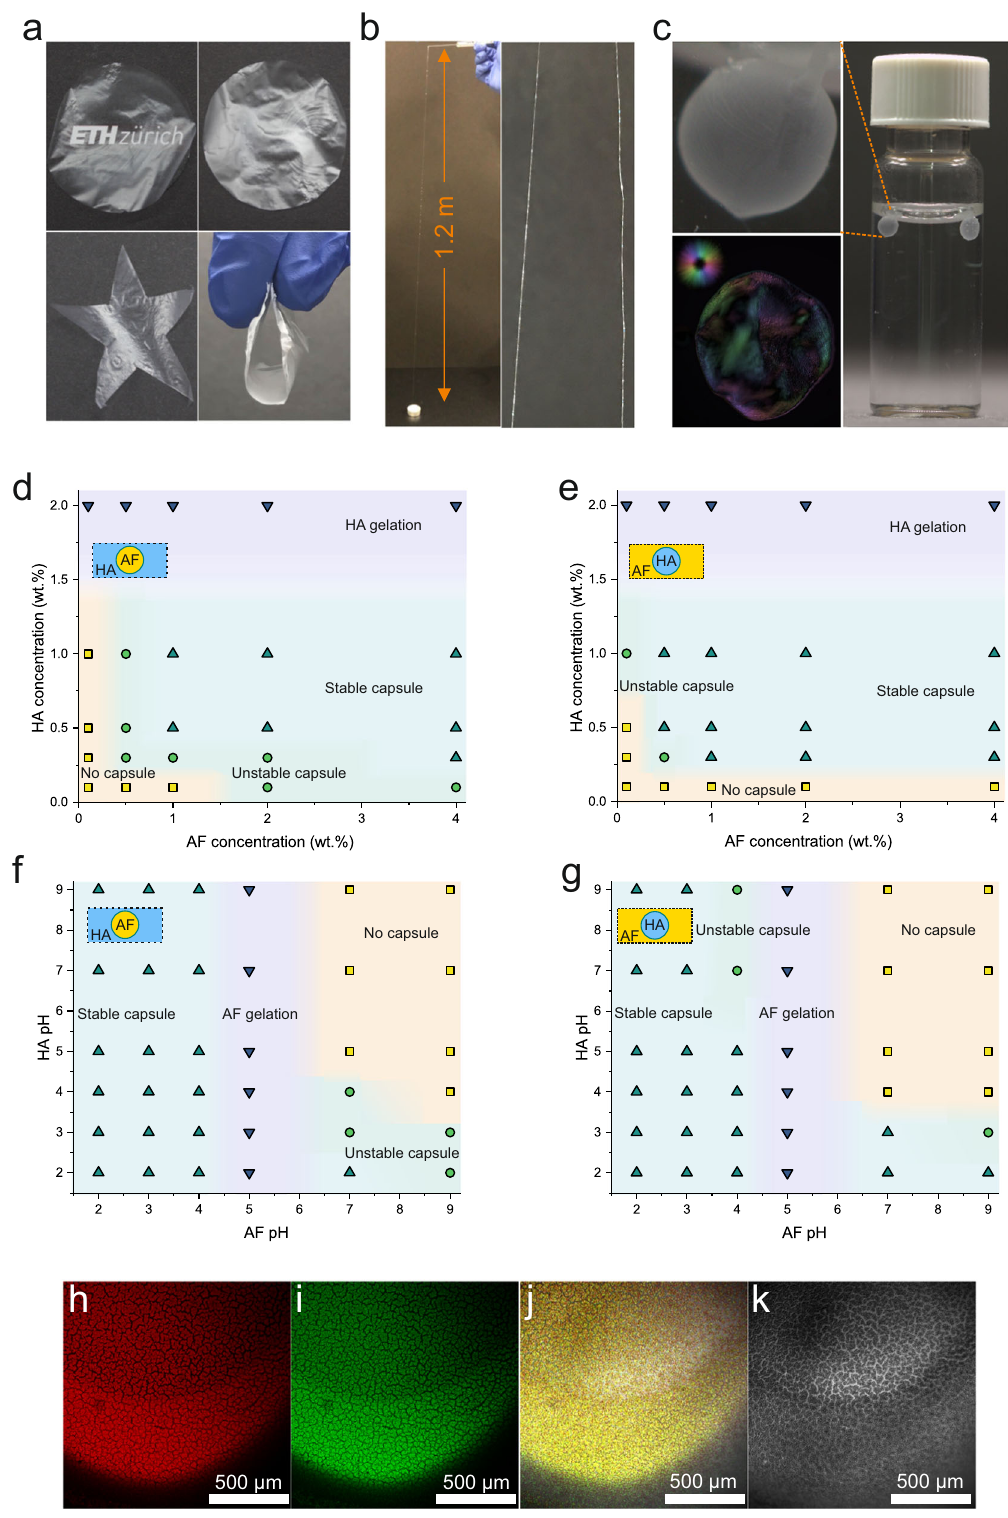
Fig. 2 | Various amyloid fi brils (AF)- hyaluronicacid (HA) coacervate products and the effect of major parameters on coacervate capsules. Photographs of a fi lms, b fi bers and c capsules formed by coacervation of AF and HA (The colorful image in panel c shows the direction of the fi brils in the plane, see the colormaps in the top-right corner). d Concentration phase diagram for producing capsules (pH 3). AFastheinnerphaseandHAastheouterphaseand e HAastheinnerphaseandAFas theouterphase. f pHphasediagramforproducingcapsules(AF2wt.%andHA1wt.%). AFastheinnerphaseandHAastheouterphaseand g HAastheinnerphaseandAFas